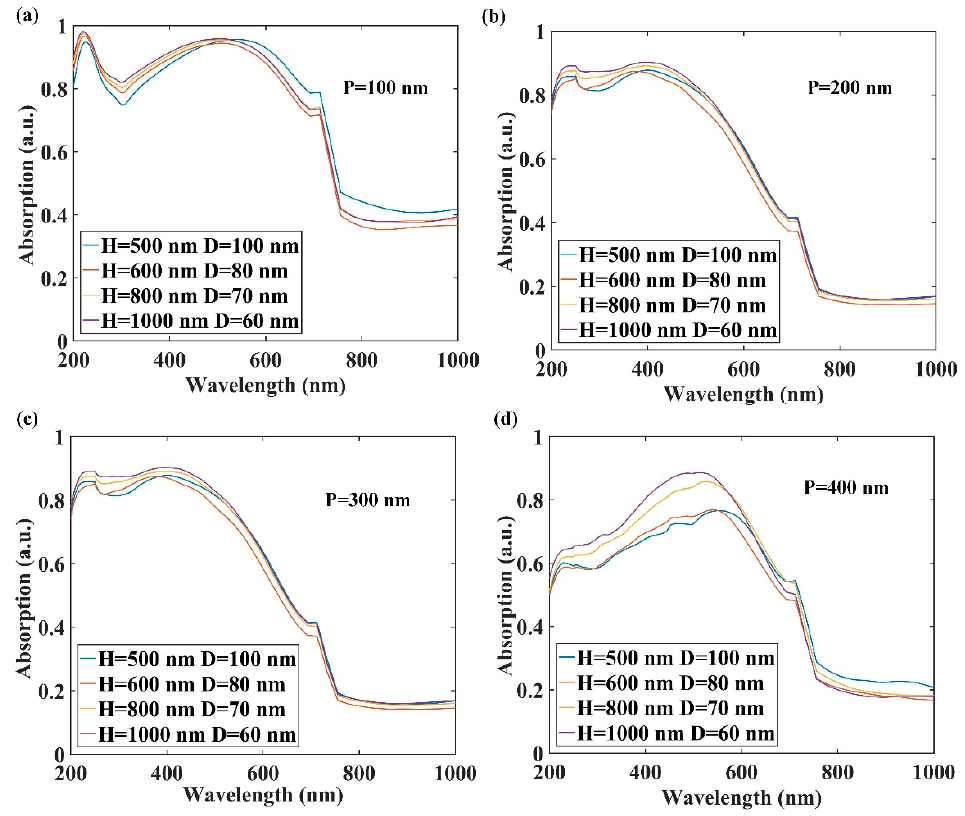
Figure 2. Light absorption enhancement in anodic aluminum oxide pores with embedded CdSe quantum dots at periodic spaces of ( a ) P = 100 nm, ( b ) P = 200 nm, ( c ) P = 300 nm, and ( d ) P = 400 nm.